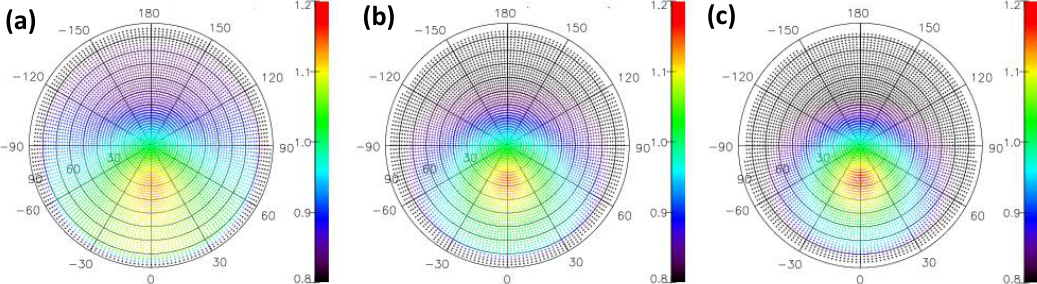
Figure 3. Example of BRDF polar plots at the RRV desert surface on 30 July 2015 created from the MODIS MCD43B1 product. Latitude, longitude and solar zenith angle are 38.471 degrees, −115.653 degrees and 25 degrees, respectively. The radial direction is the viewing zenith angle where the center is for a nadir view angle (viewing zenith = 0 degrees). The outer edge is a view to the horizon (view zenith angle = 90 degree). The azimuth is represented as the direction from North. An azimuth of 90 degree would be looking from the east. The BRDF plots correspond to MODIS ( a ) Band 2 (841–876 nm) ( b ) Band 6 (1628–1652 nm) and ( c ) Band 7 (2105–2155 nm), respectively.